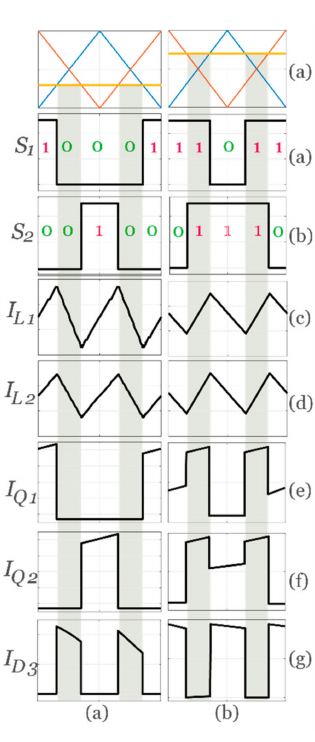
Figure 5. Key waveforms of the proposed converter ( a ) D < 0.5. ( b ) D >